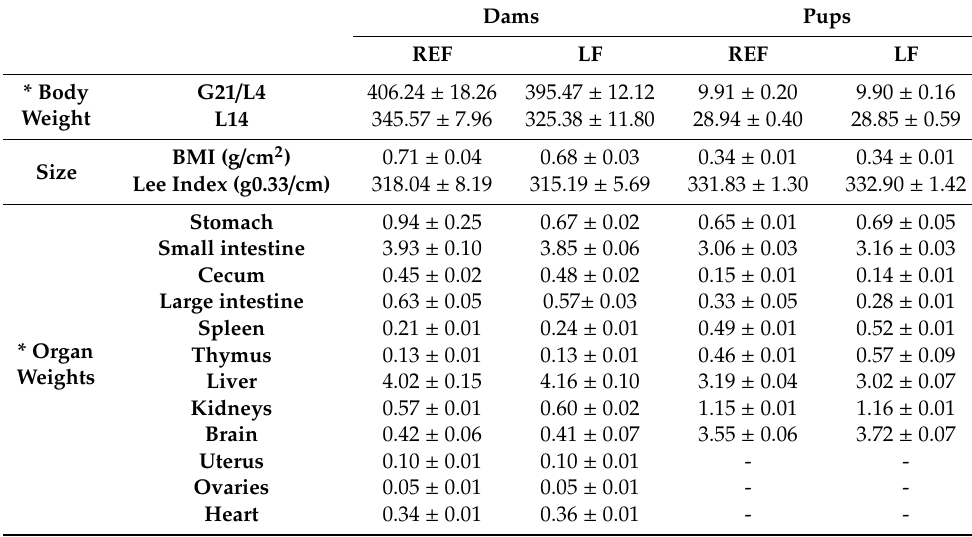
Table 2. Growth and relative organ size of dams and